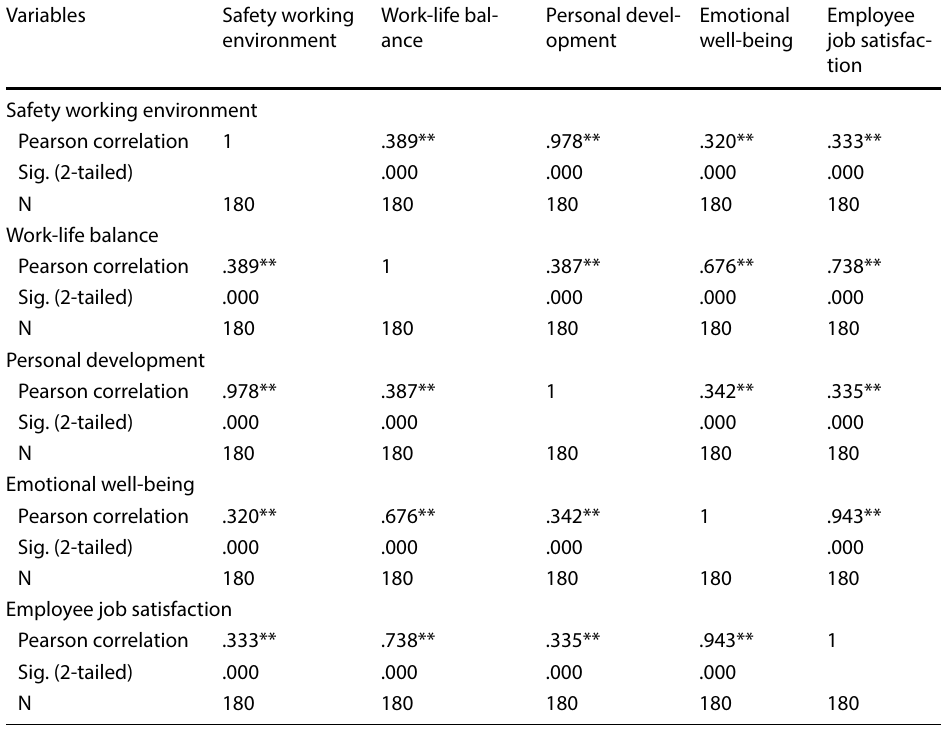
Table 3 Correlation